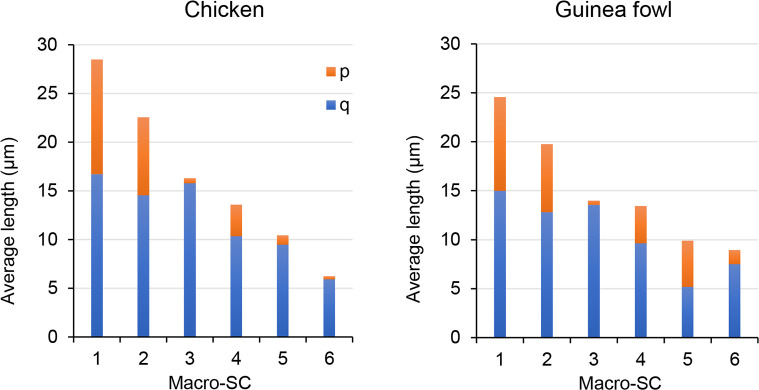
Graphic representation of the macro-SCs.Each bar represents a synaptonemal complex. The total height is the average SC length in micrometers. The short (p) and long (q) arms are shown in different colors to ease the comparison of the arm ratios.